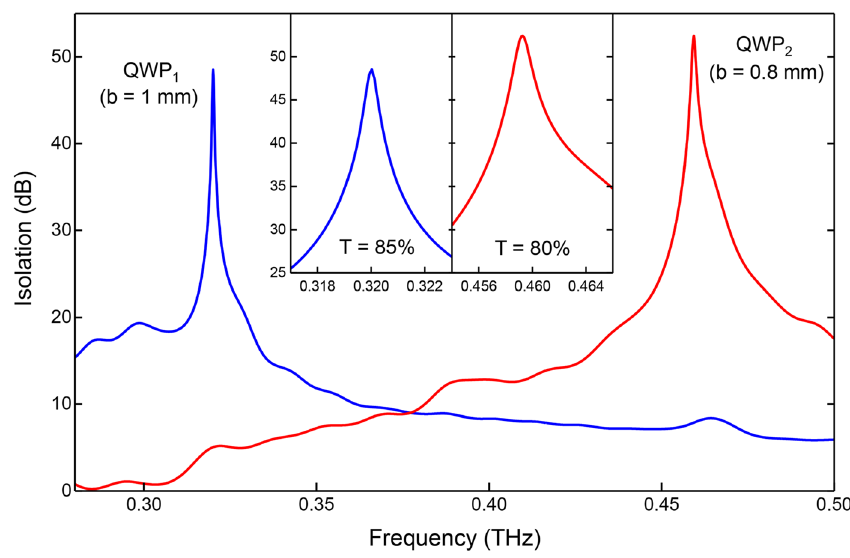
Figure 7. Measured isolation curves. Results are shown for the QWP 1 (blue curve) and QWP 2 (red curve) designs, with close-up views of the isolation peaks shown